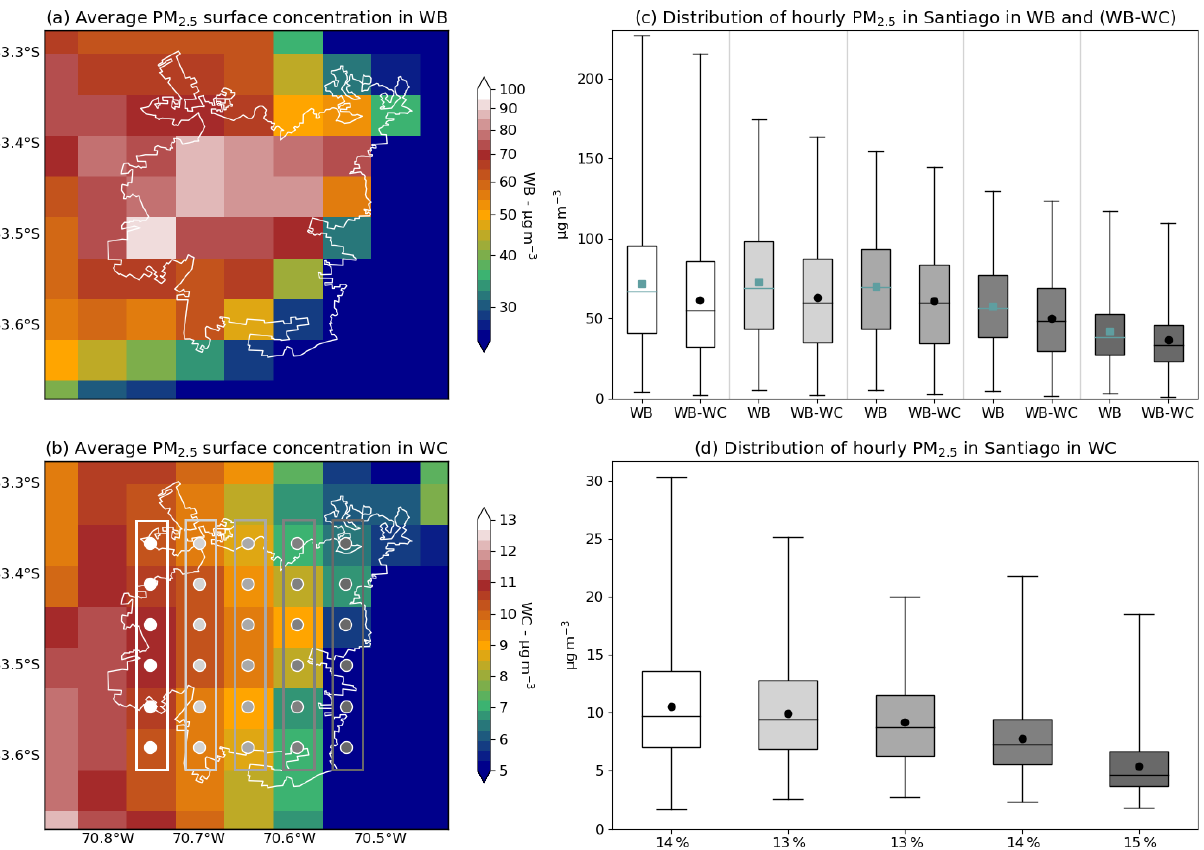
Figure 6. (a) Average ground-level PM 2 . 5 concentration in scenario WB. The white contour shows the boundaries of Santiago. Panel (b) is the same as panel (a) for scenario WC. (c) Distribution of hourly PM 2 . 5 surface concentration in WB and WB–WC. Boxes show the average, median, minimum, maximum, and first and third quartiles. Shades of gray correspond to the zones defined in (b) on which an average is made. Panel (d) is the same as panel (c) for scenario WC. Percentages indicate the relative average contribution of